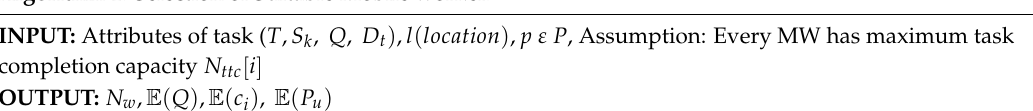
Algorithm 1 : Selection of Suitable Mobile